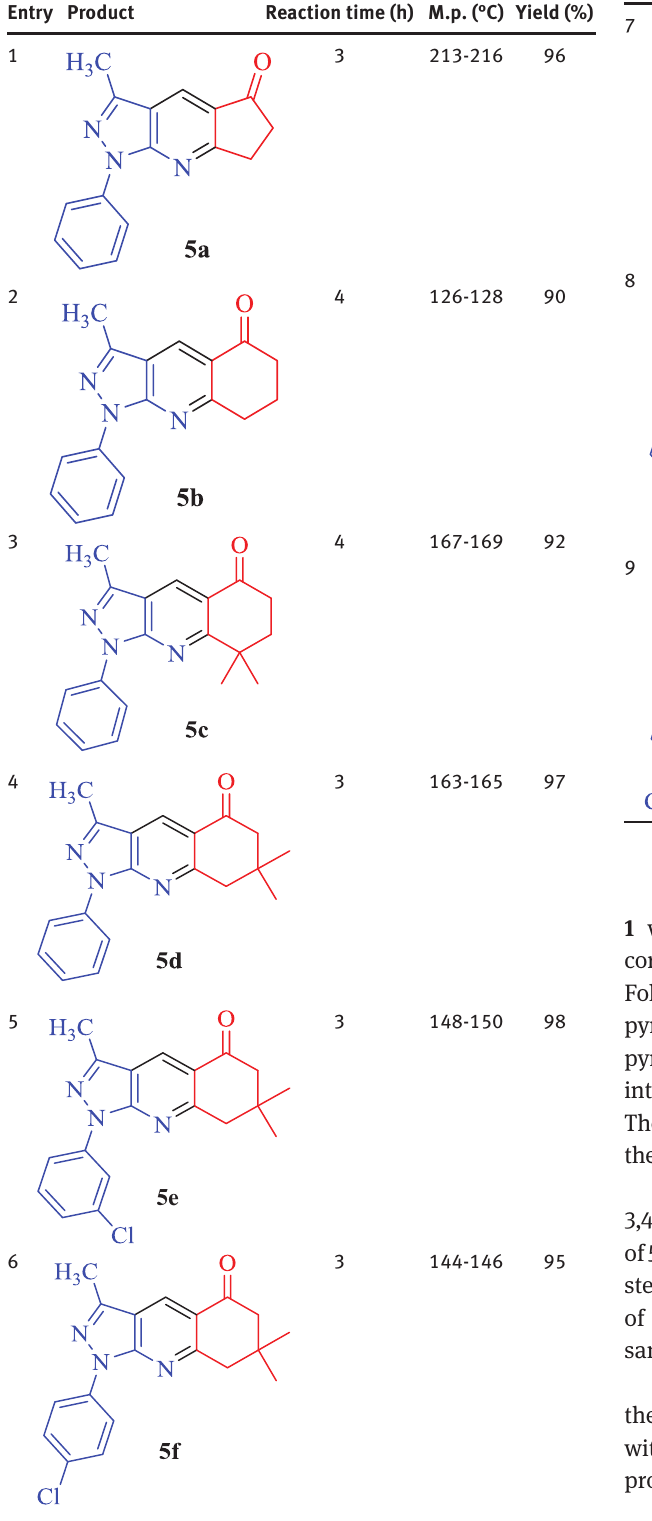
Table 2 : The reaction condition, melting points and yields of products 5a-i . Entry Product